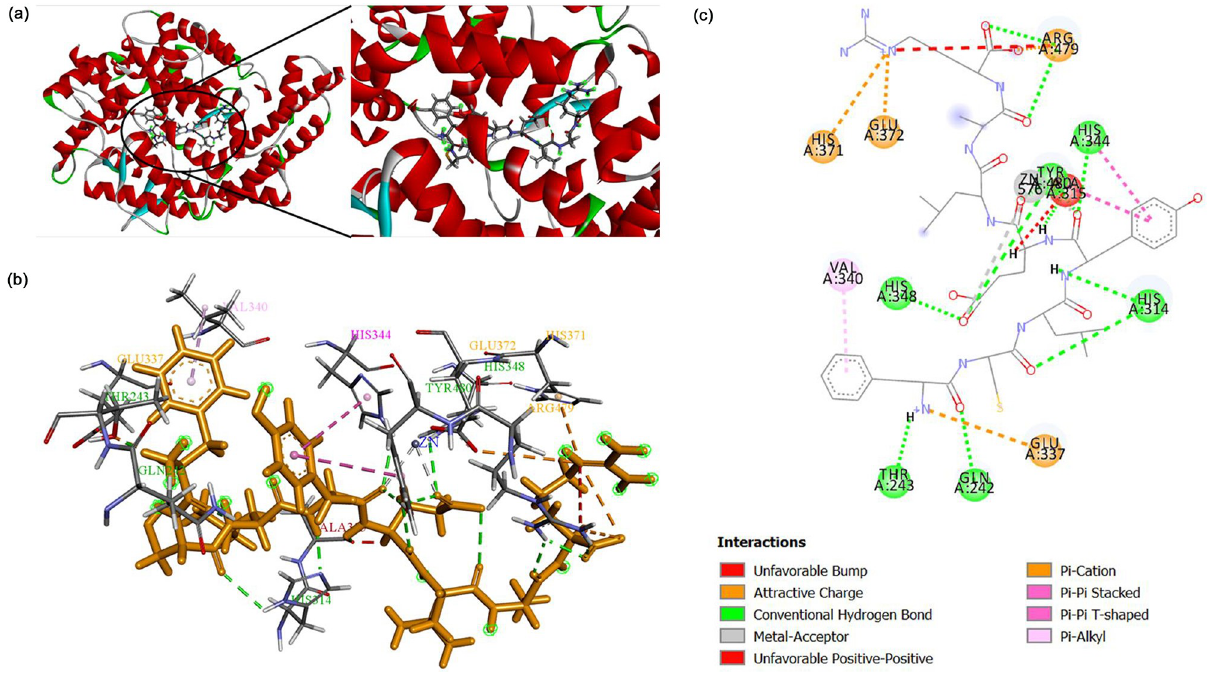
Fig 7. Simulations of molecular docking for FCLYELAR binding to ACE (PDB: 1O8A). (a) Broad overview and narrow localized perspective for the 3D structure prediction of the peptide-ACE complex; (b) Anticipated interactions involving the synthesized FCLYELAR peptides and ACE residues (Images produced using Discovery Studio Visualizer v19.1.0 software), (c) 2D representation of the anticipated interactions involving the synthesized FCLYELAR peptides and ACE molecules (Images produced using Discovery Studio Visualizer v19.1.0 software).